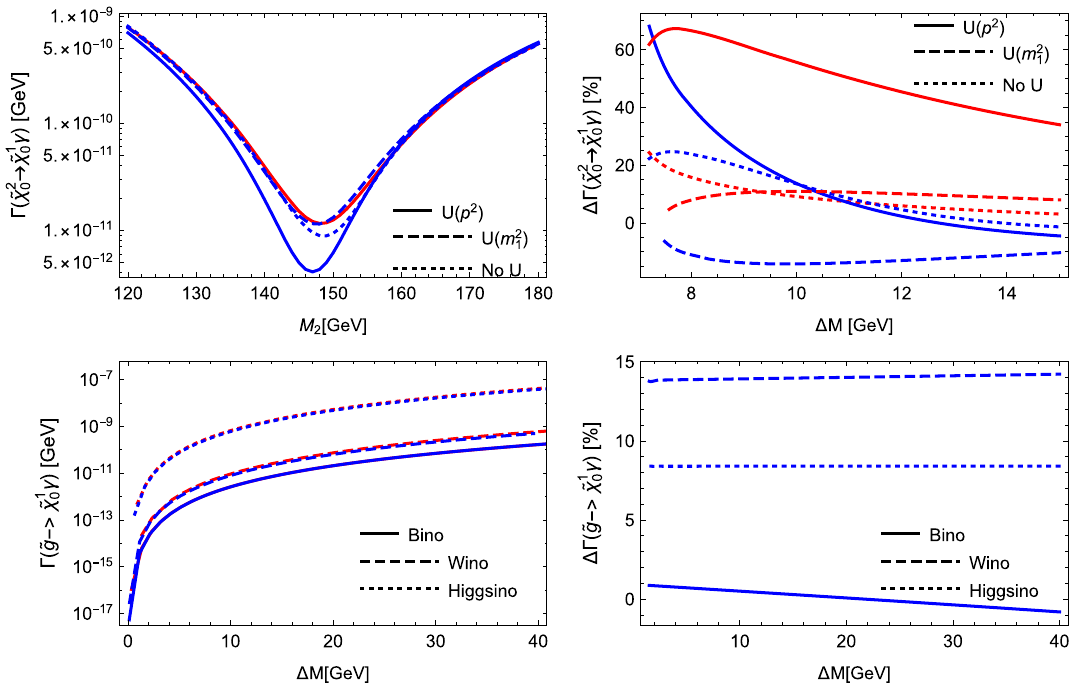
case of the neutralino decay we show the impact of the U -factors, while for the gluino decays we compare the different kind of neutralinos. The colour code for the upper right figure is: blue for a bino LSP and red for a wino